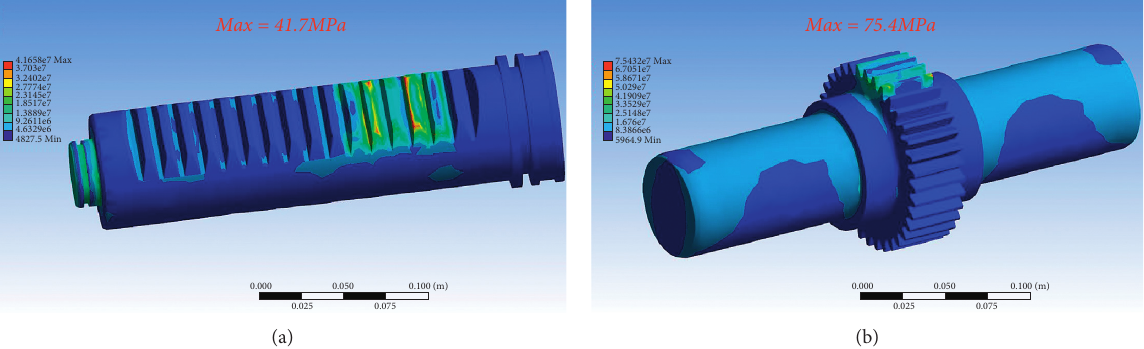
Figure 9: The Mises stress distribution on the teeth of the rack rod and gear wheel. (a) The rack rod in the piston. (b) The gear wheel in the